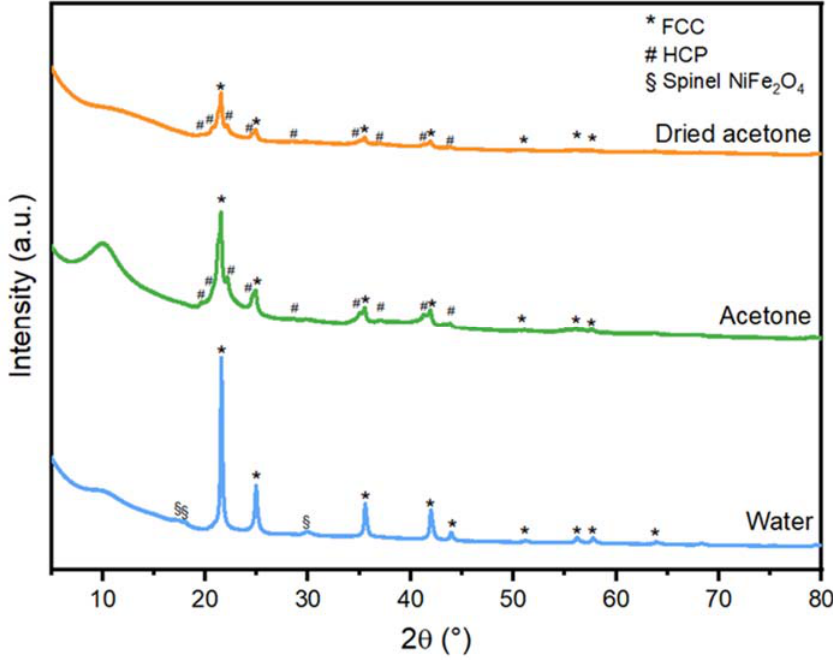
Figure 2. Synchrotron XRD profiles of the FeNi NPs ablated in different liquids. The ablation in acetone or dried acetone produced the FCC phase and the HCP phase, with a small volume of spinel NiFe 2 O 4 phases (barely visible in this graph). Meanwhile, the ablation in water produced the FCC phase and NiFe 2 O 4 phase. The complete indexing is presented in the supplementary information (Figure S2). Table 1. The crystalline phase composition of FeNi NPs synthesized in different ablation liquids. The weight fraction of the HCP FeNi phase was extracted from the SXRD profile by Rietveld